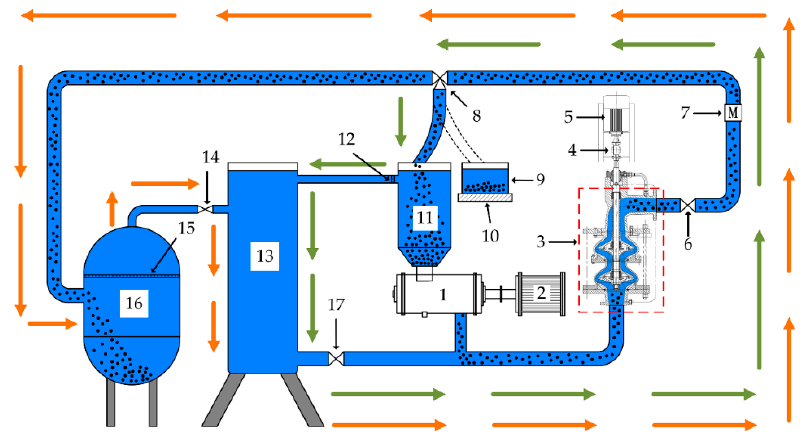
Figure 4. Schematic diagram of slurry transport system: (1) Feeding particles machine, (2) Motor 1, (3) Slurry transport pump, (4) Torque meter, (5) Motor 2, (6) Butterfly valve, (7) Electromagnetic flowmeter, (8) Three-way valve, (9) Calibration box, (10) Platform scale, (11) Particle tank, (12) Filter, (13) Water tank, (14) Ball valve, (15) Filter, (16) Solid–liquid separation tank, and (17) Gate valve.